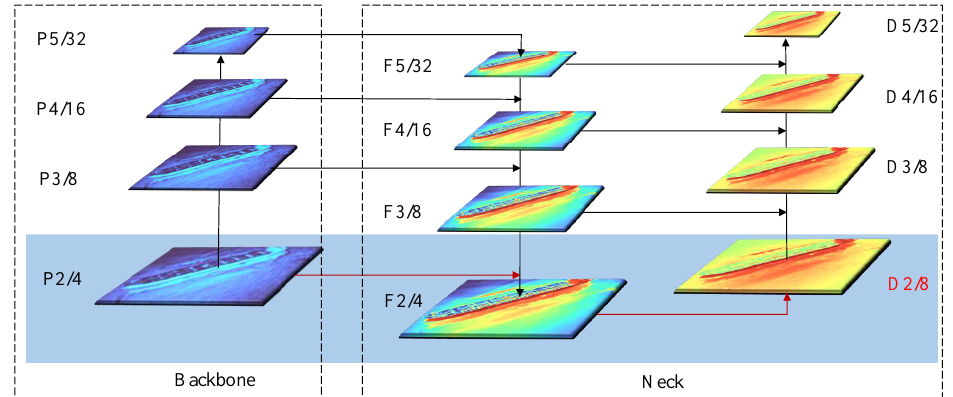
Figure 3. Structure with high-resolution detection layer P2. Red lines represent the newly added P2